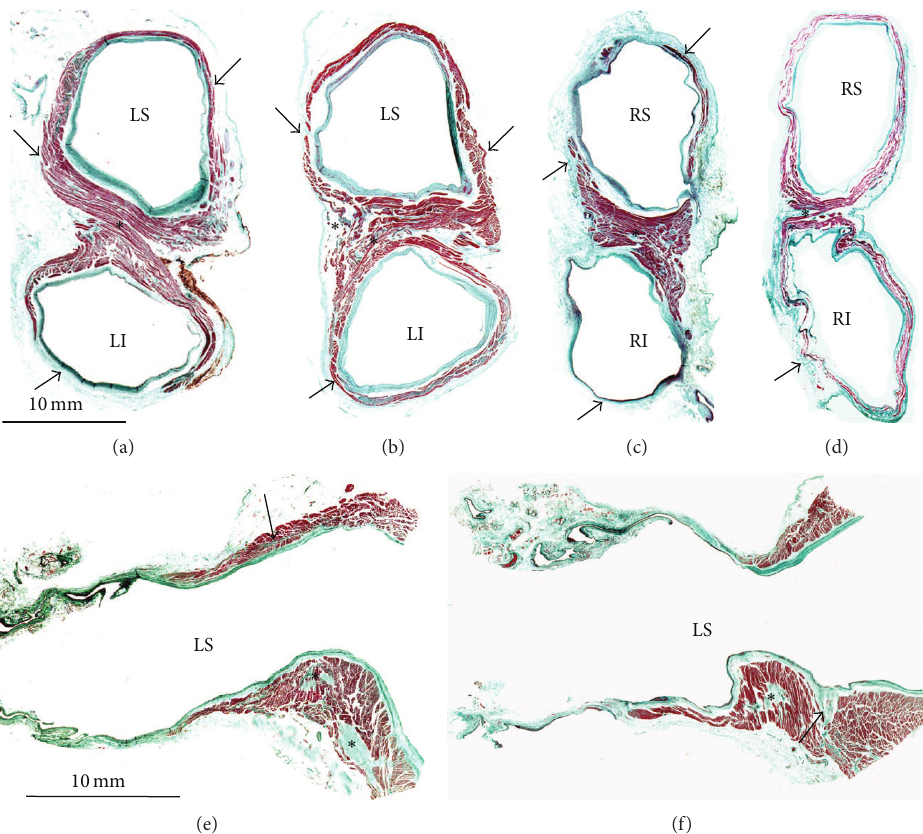
Figure 6: Cross-histological sections of the left (a), (b) and right (c), (d) pulmonary veins stained with Masson’s trichrome showing variations in circumferential thickness of the myocardial sleeves (arrows). Note the interpulmonary myocardial connections ( ∗ ) between the superior and inferior veins and that the inferior veins tended to have less myocardial coverage than the superior veins. Longitudinal histological sections (e), (f) with Masson’s trichrome stain show the thicker atrial wall becoming thinner at the entrance of the left superior pulmonary vein to form the muscular sleeve, which tapers toward the lung. Note the presence of gaps of connective tissue bridges between the myocardial fibers (arrows) and small areas of myocardial degeneration with fibrous replacement ( ∗ ). LI = left inferior pulmonary vein, LS = left superior pulmonary vein, RI = right inferior pulmonary vein, and RS = right superior pulmonary